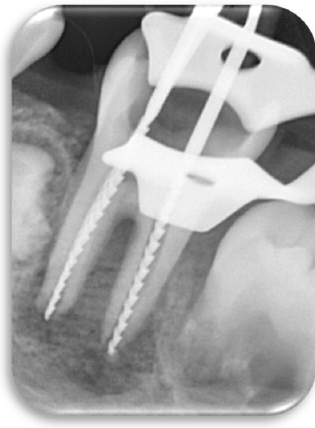
Figure 2. Determining the working length radiographically.